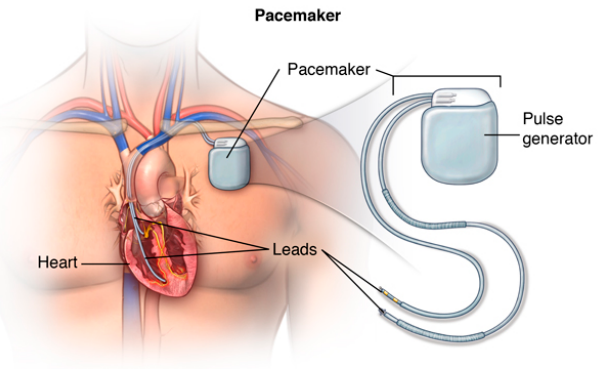
Figure 14. A pacemaker implanted into the human body; https://www.stanfordchildrens.org/ (accessed on 19 August